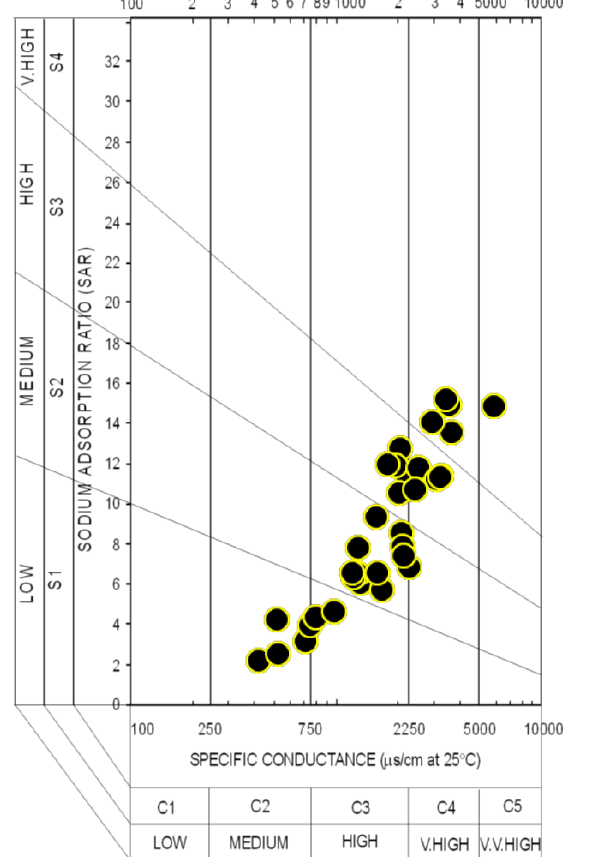
Figure 11. USSL Figure 11. USSL classification. Table 8. Classification of groundwater samples for irrigation.